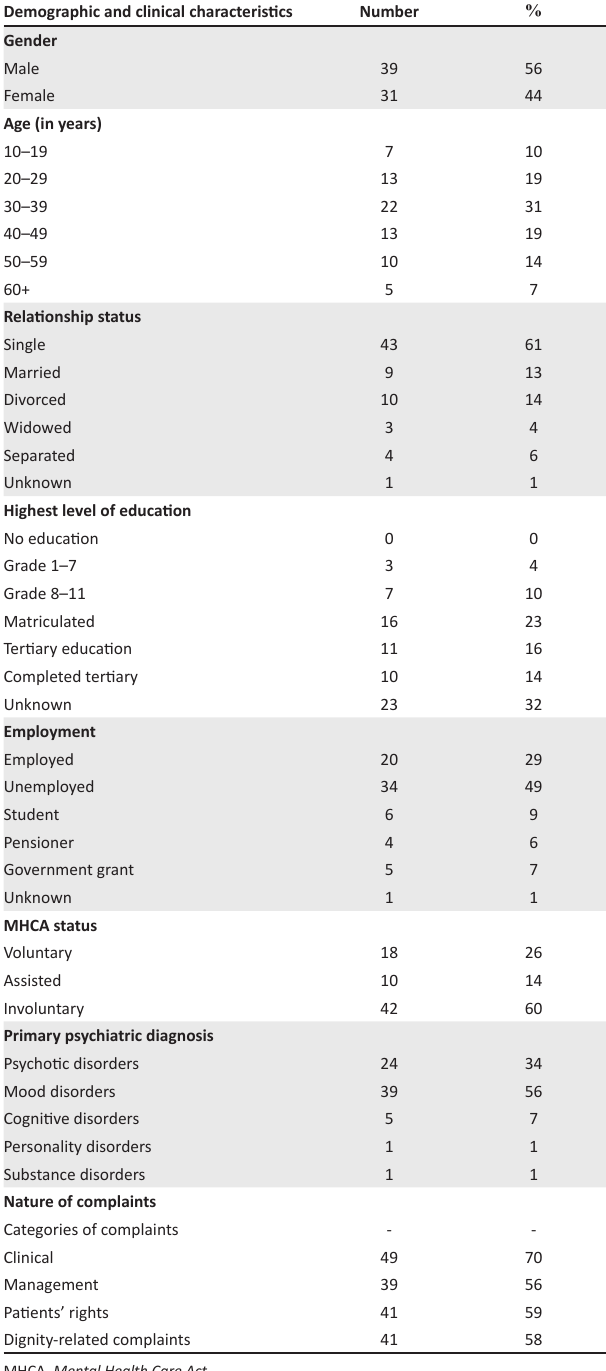
TABLE 1: Demographic characteristics, clinical profile and nature of complaints ( n =